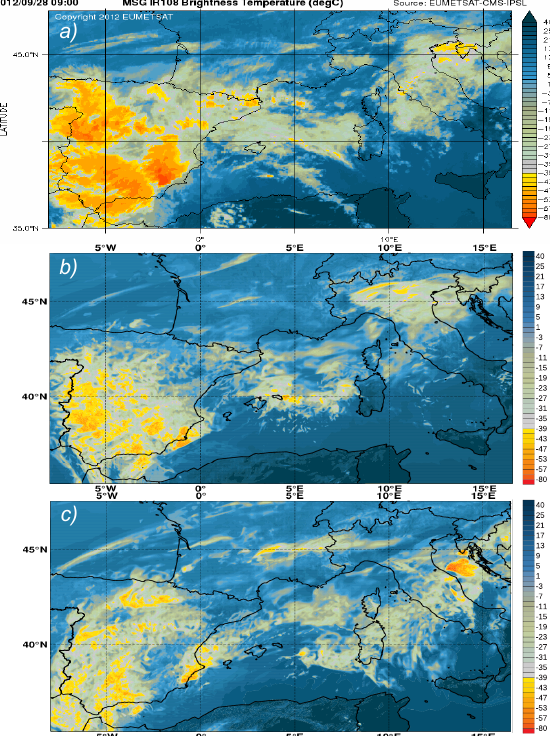
Figure 23. Brightness temperatures ( ◦ C) observed with SEVIRI on 28 September 2012, 09:00UTC (a) and simulated with AROME- WMED 9h forecast from 28 September 2012, 00:00UTC (b) and with 33h forecast from 27 September 2012, 00:00UTC (c)